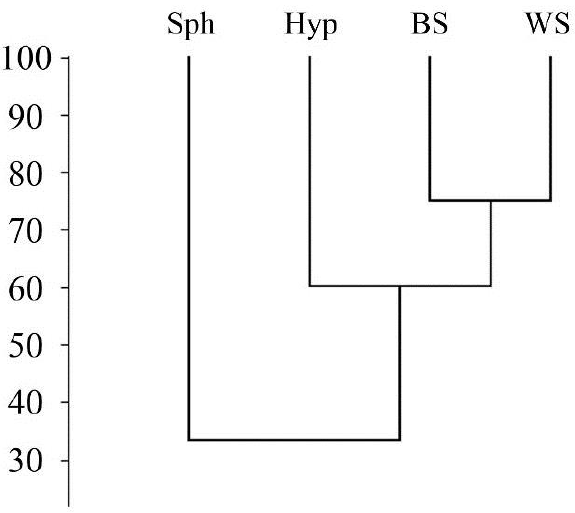
Figure 9. Dendrogram showing the Bray-Curtis similarity (%) of microhabitat types by species diversity of centrohelids. Abbreviations: Sph = extracts of Sphagnum mosses; Hyp = extracts of Hypnales mosses; BS = bottom sediment; WS = water surface.